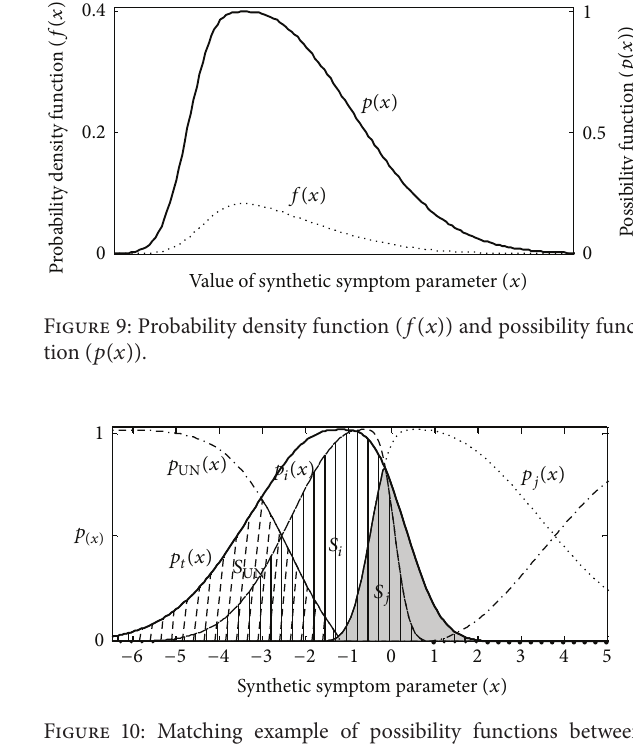
Figure 10: Matching example of possibility functions between model states and diagnostic